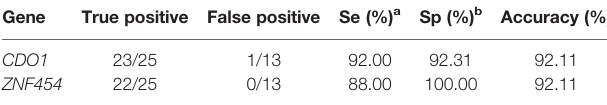
TABLE 1 | Se, Sp, and accuracy of DNA methylation of CDO1 and ZNF454 using fi rst-generation sequencing.